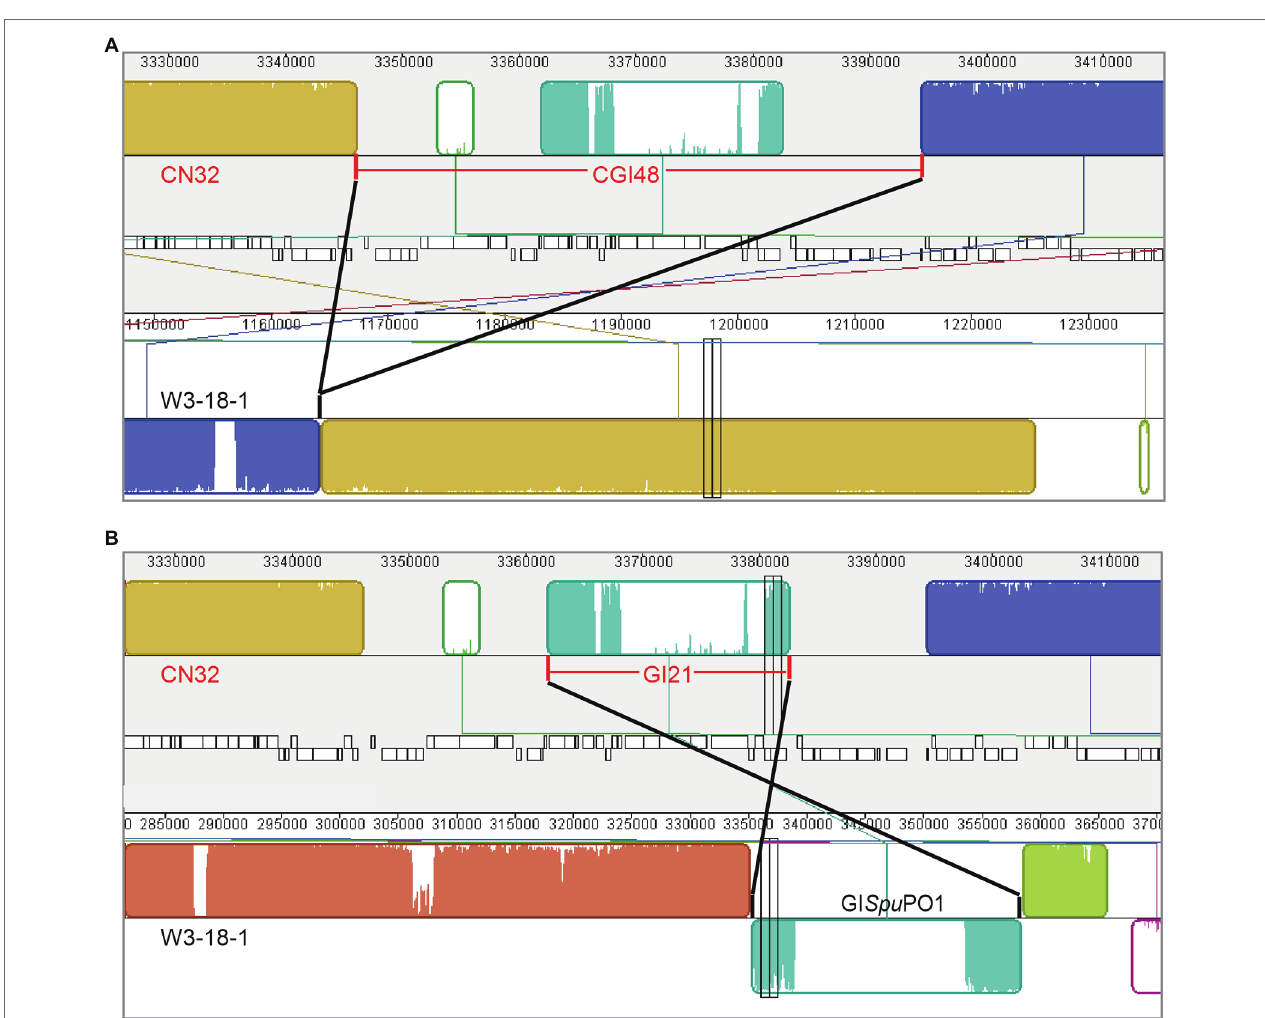
FIGURE 1 | Schematic view of the composite island CGI48 in the CN32 genome. CGI48 (A) and its component genomic island GI21 (B) were identified by comparing the genome sequence of S. putrefaciens CN32 (CP000681) with S. putrefaciens W3-18-1 (CP000503) with